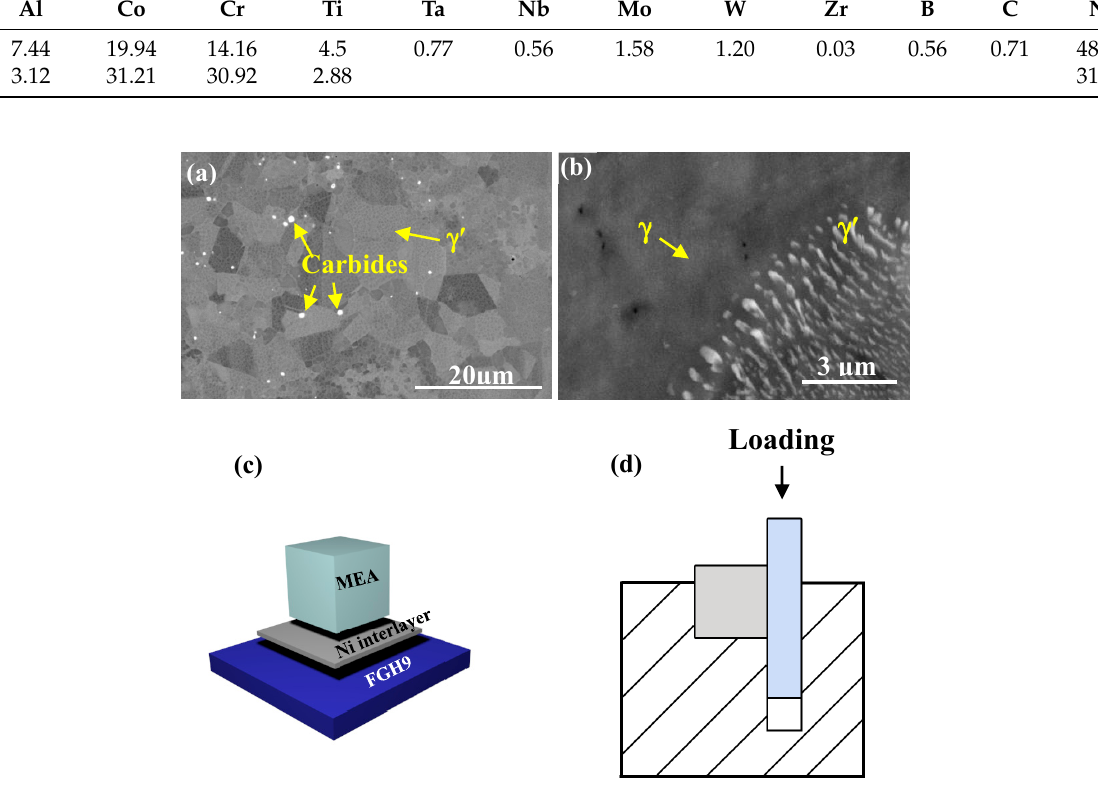
Figure 1. The microstructure of base materials and the work piece and shear test apparatus showing ( a ) FGH98, ( b ) Al 3 Ti 3 (CrCoNi) 94 , ( c ) work piece, and ( d ) shear test apparatus